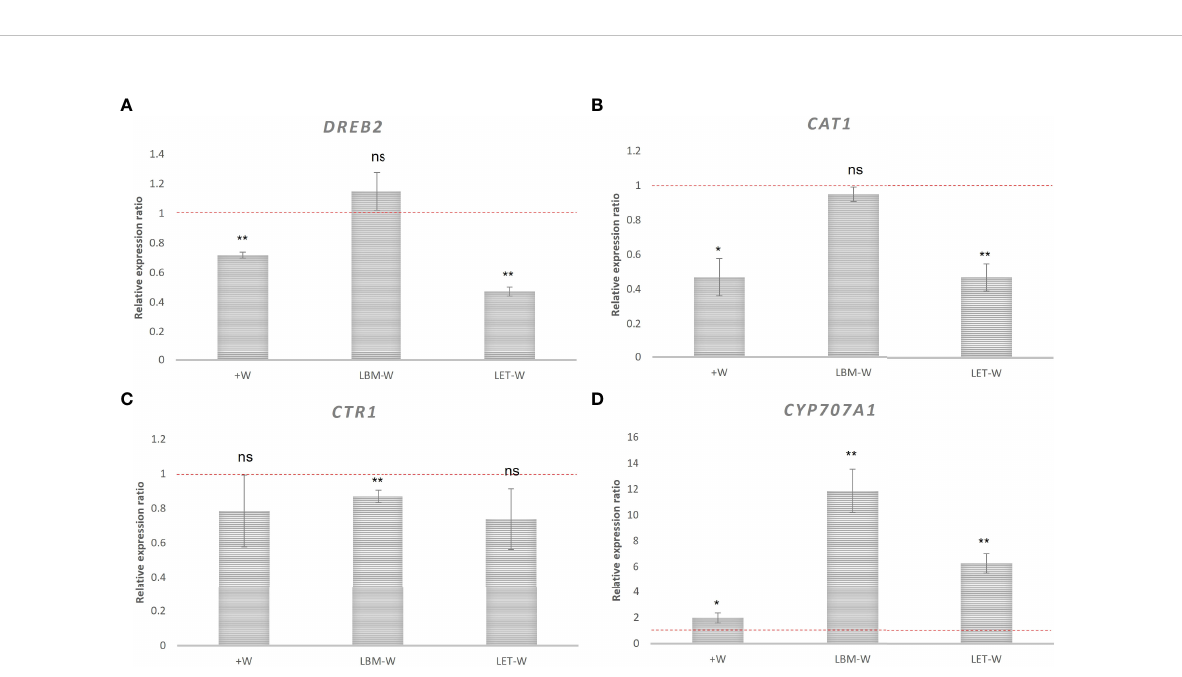
FIGURE 4 Relative expression of wheat genes related to drought stress: (A) DREB2 , (B) CAT1 , (C) CTR1 , and (D) CYP707A1 . Relative expression ratio of wheat plants inoculated with rhizobia strains LBM and LET under water-stress conditions (LBM-W) (LET-W) and non-water stress/non- inoculated plants (+W) with respect to water-stress/non-inoculated wheat plants (-W). Data were analyzed using 2 − DD CT method described by Pfaf fl (2001). Mean values and standard deviations of the relative expression of three biological replicates. The independent samples t -test was used to determine signi fi cant differences in relative gene expression (signi fi cance level: ** 0.001 < p ≤ 0.01; * 0.01 < p ≤ 0.05; ns, not signi fi cant). Values below the red dashed line are